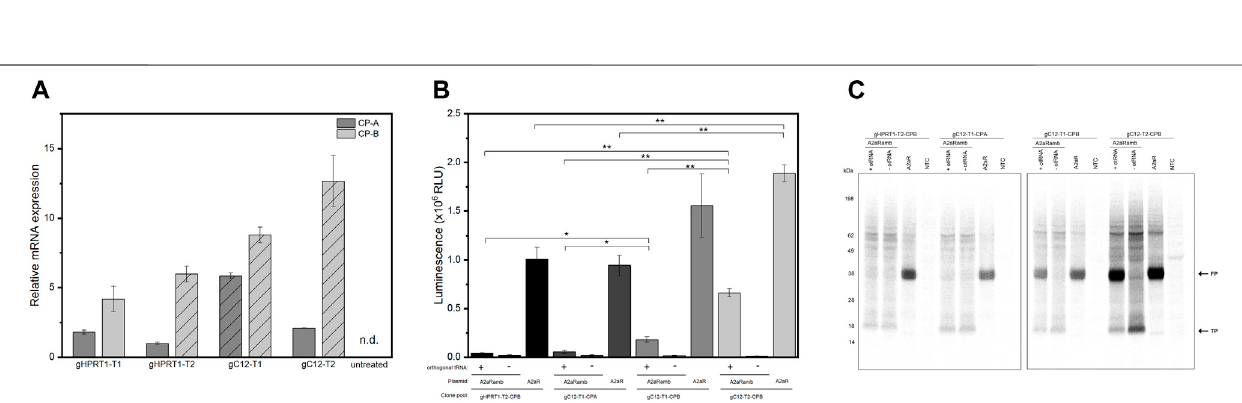
FIGURE4| CHOclonepoolsstabletransfectedwitheAzFRS. (A) RelativeeAzFRSmRNAexpressionlevelsofCHOclonepools.Thelinepatternindicatesselected clonepoolsforcell-freesynthesis.Experimentswereperformedintechnicaltriplicatesandbarsrepresentthestandarddeviation. (B) Luciferaseassaybasedoncell-free synthesized A2aR and A2aRamb constructs using cell lysates based on clone pools gHPRT1-T2-CPB, gC12-T1-CPA, gC12-T1-CPB and gC12-T2-CPB. Samples with a plus or minus indicate the addition or absence of orthogonal tRNA, respectively. Luminescence signals of cell-free reactions without a template (NTC) were subtracted from sample signals. Data are shown as mean ± SEM ( n = 3). A Welch ’ s t -test was performed to determine the statistically signi fi cant differences between samples (* p -value < 0.05; ** p -value < 0.01). (C) Exemplary autoradiography of electrophoretically separated proteins of a CFPS based on the different clone pools. CP: Clone pool, n.d: not detected, otRNA: Orthogonal tRNA, FP: Full-length protein, TP: Truncated protein, NTC: No-template control.